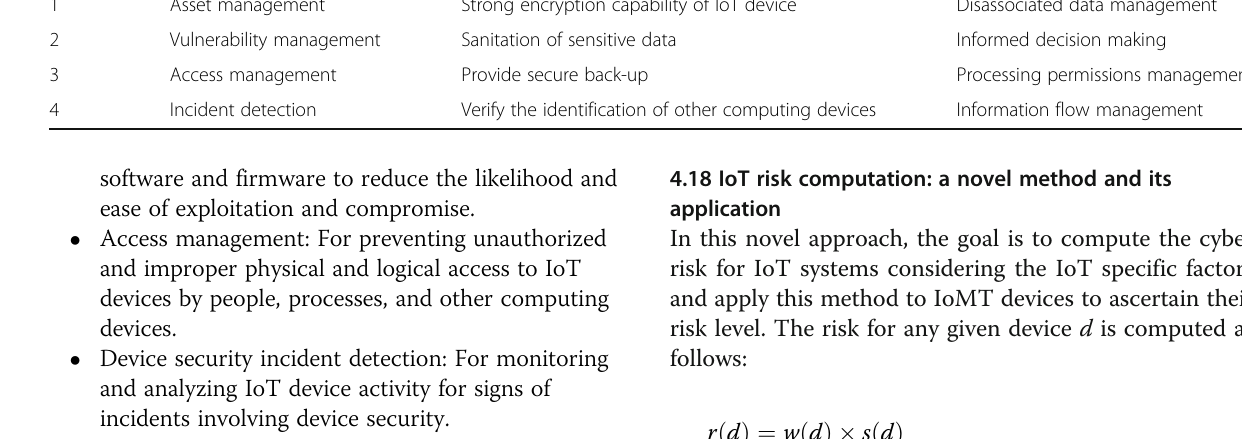
Table 3 IoT risk assessment categories of NIST S. no